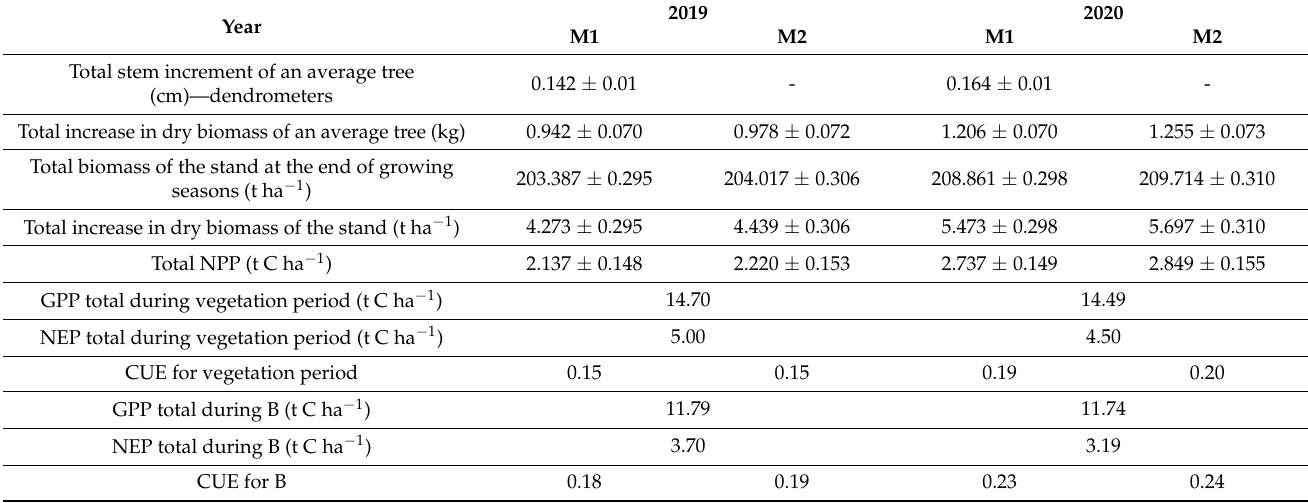
Table 3. Results of the dry biomass estimations including above- and belowground biomass for two site-specific allometric equations M1 (one equation for the whole tree) and M2 (separate formulas for tree components), based on dendrometers and in situ biometric measurements, including deadwood and understory (NPP) as well as NEP and GPP values derived from the eddy covariance observations. B—wood growth